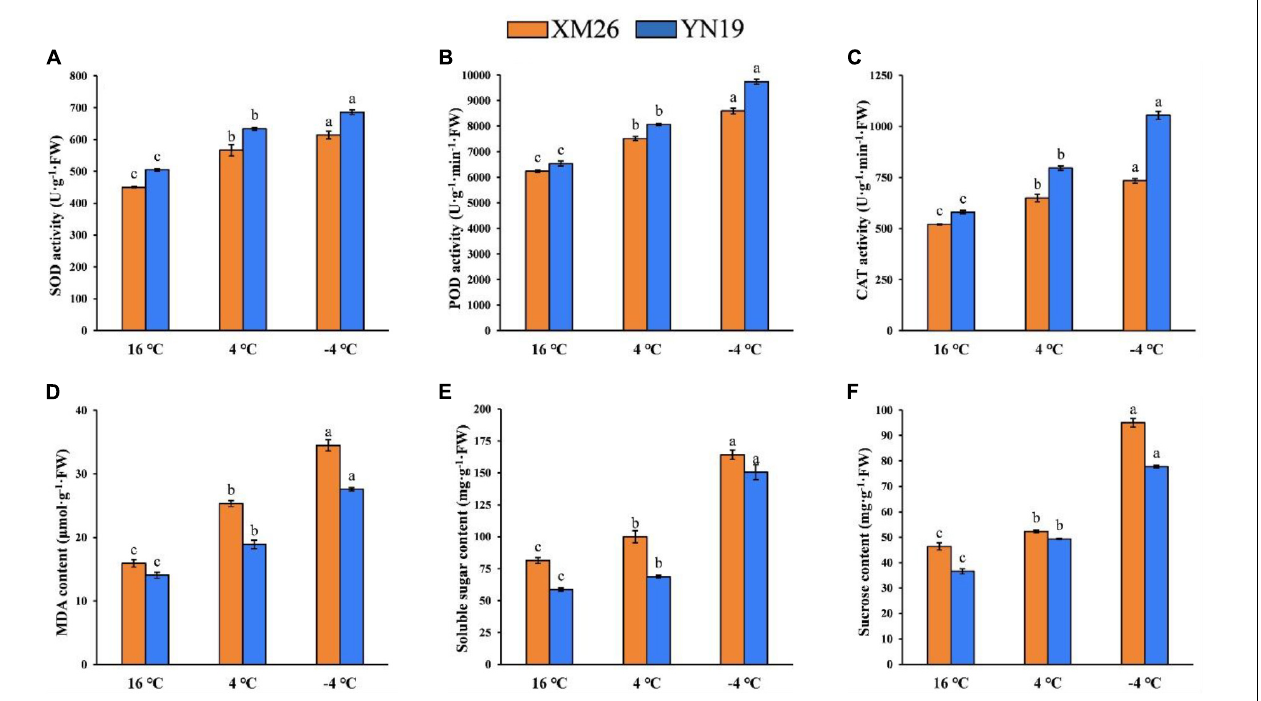
FIGURE 2 | Physiological indices of Xinmai26 (XM26) and Yannong19 (YN19) under cold stress; (A) Superoxide dismutase (SOD) activity, (B) Peroxidase (POD) activity, (C) Catalase (CAT) activity, (D) malondialdehyde (MDA) content, (E) Soluble sugar content, and (F) Sucrose content. Data mean ± SD ( n = 3). Different lowercase letters on the columns indicate significant differences between temperature treatments ( P ≤